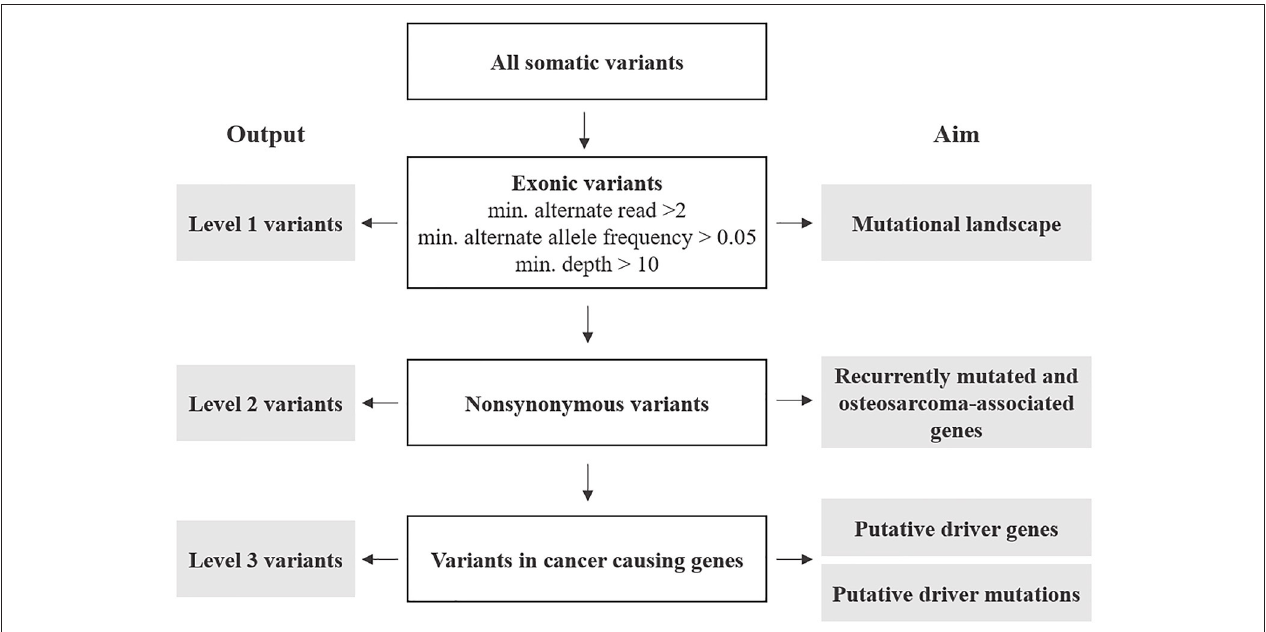
FIGURE 1 | Post-processing of somatic variants: outline of selection criteria, categorization, and analyses.